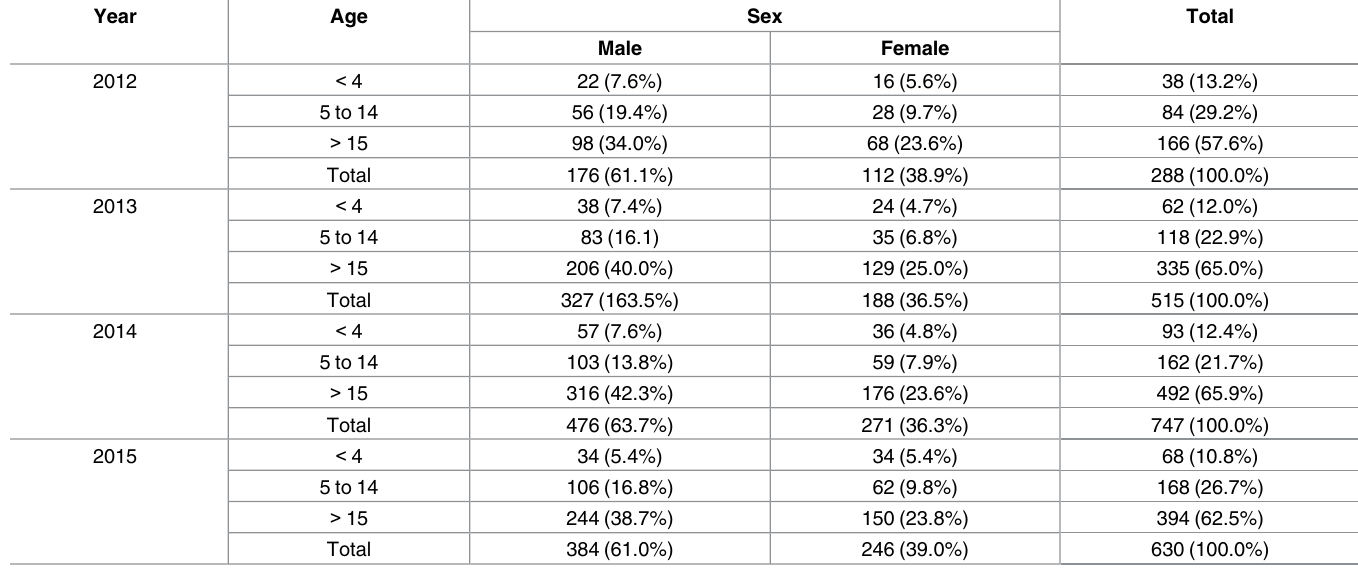
Table 1. Demographic distribution of human rabies exposure casesreceivedPEP at Suhul hospital during 2012, 2013, 2014 and 2015. Year